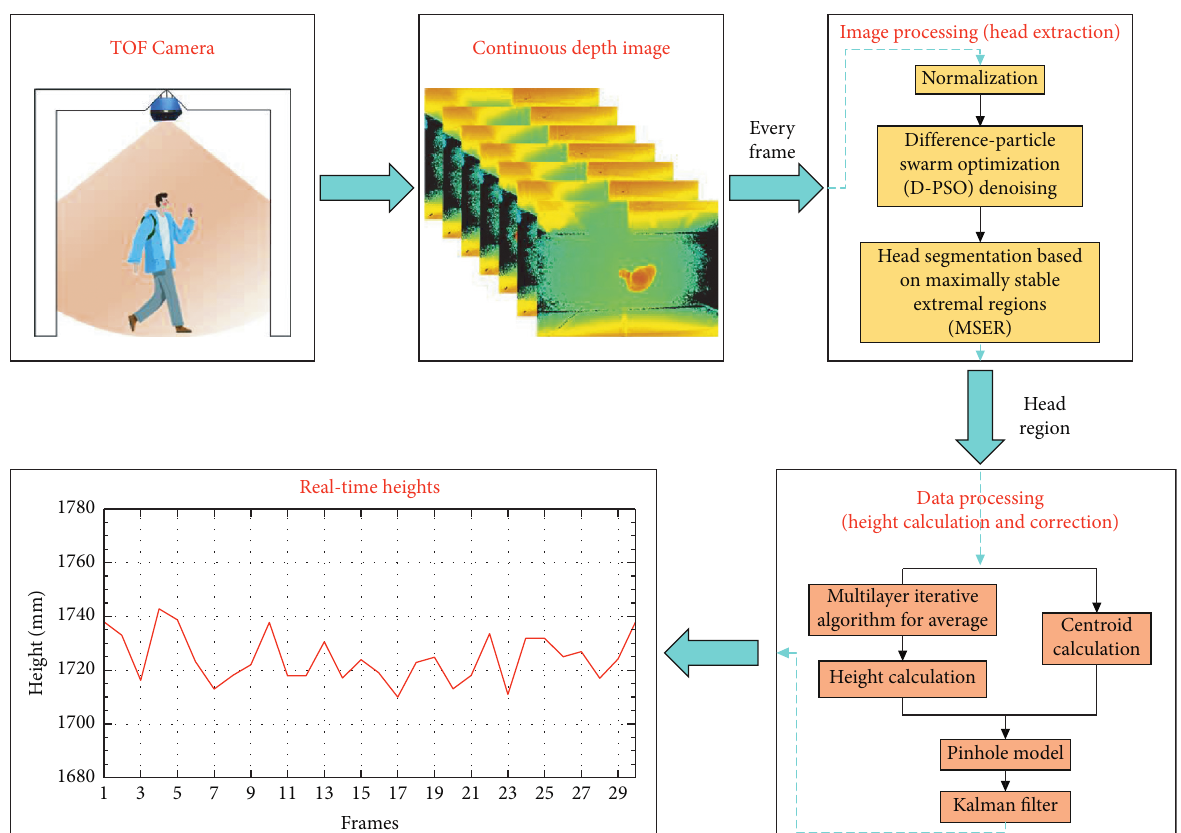
Figure 1: Overall framework of the proposed method.